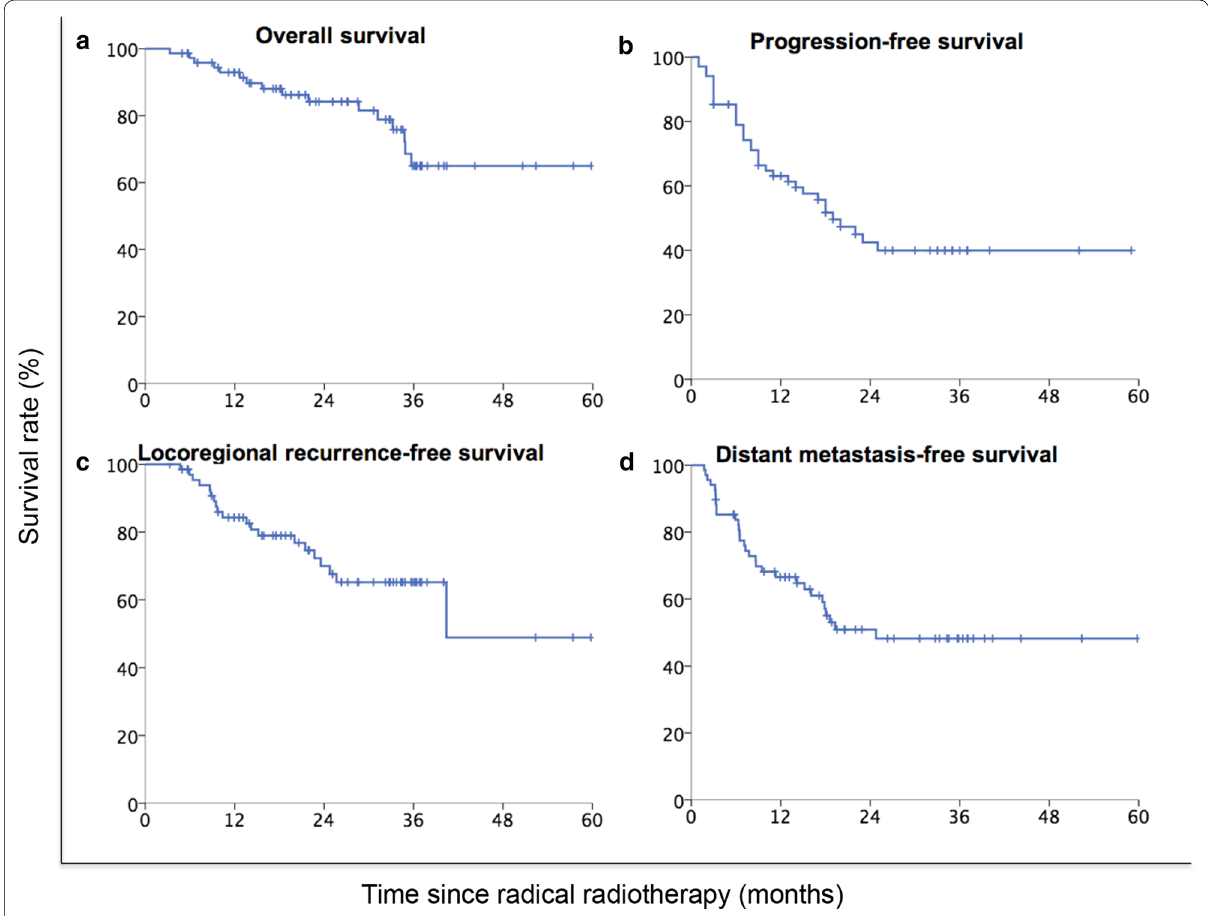
Fig. 1 Kaplan–Meier survival curves of non‑small cell lung cancer (NSCLC) patients with postoperative locoregional recurrence treated with radical radiotherapy. a Overall survival curve; b progression‑free survival curve; c locoregional recurrence‑free survival curve; d distant metastasis‑free survival